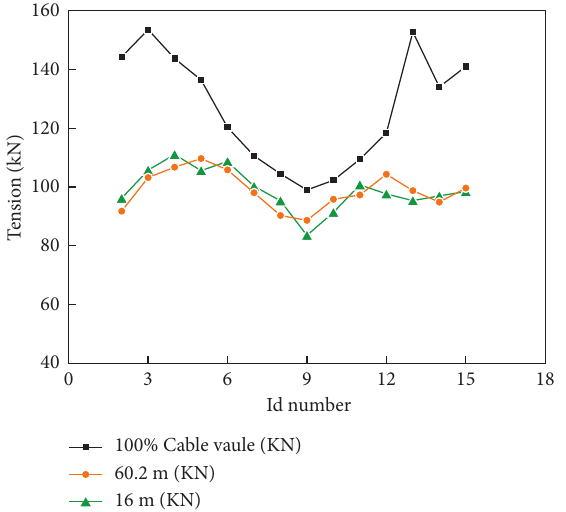
Figure 3: Test curve of the water pressure test of the magnetic flux sensor.